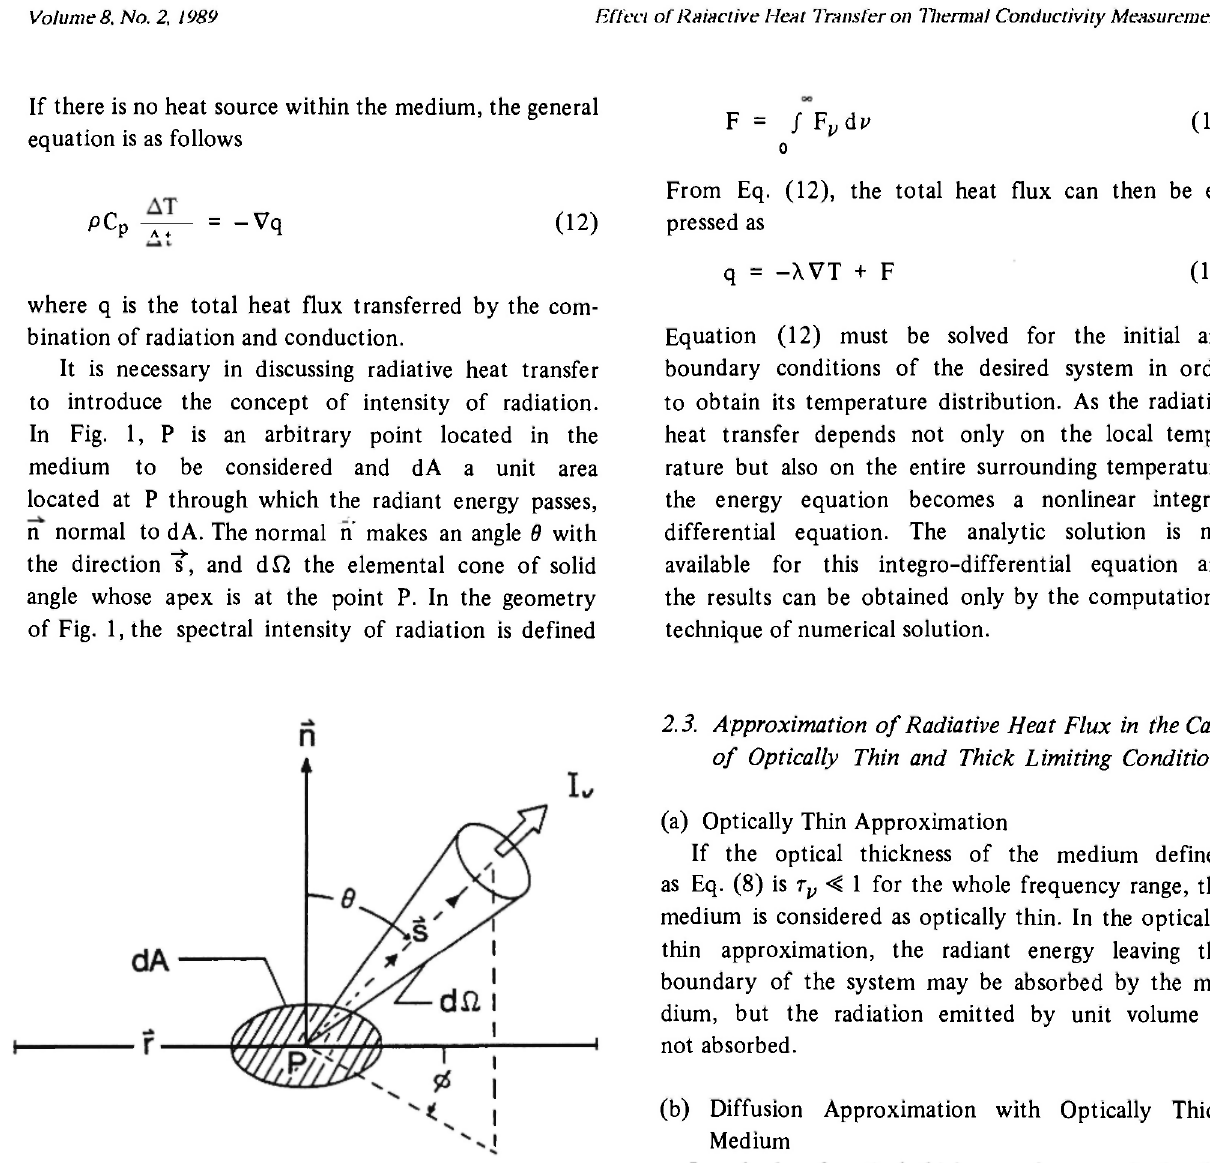
Fig. 1. Geometry used to define the radiation